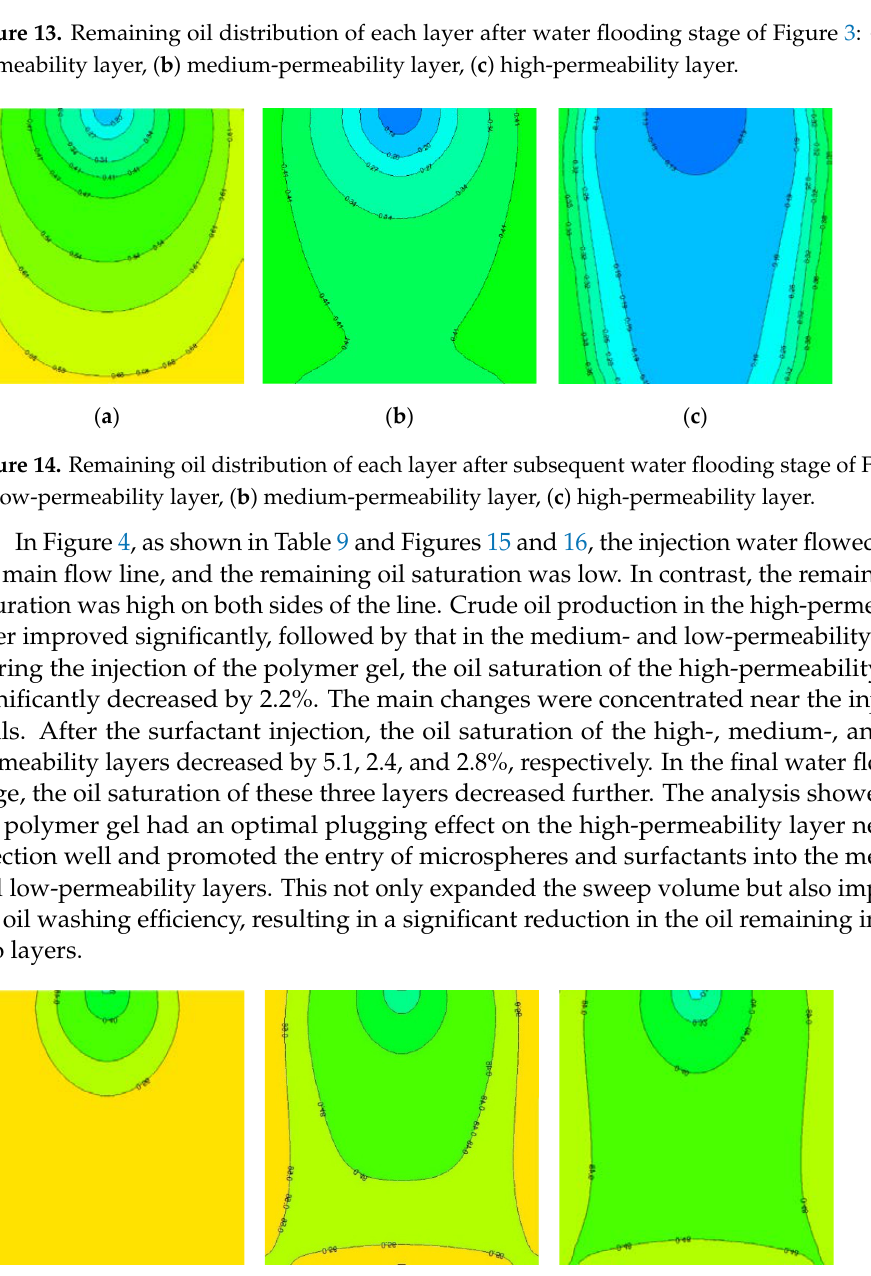
( c ) Figure 16. Remaining oil distribution of each layer after subsequent water flooding stage of Figure 4: ( a ) low-permeability layer, ( b ) medium-permeability layer, ( c ) high-permeability layer . Table 9. The remaining oil saturation (%) results of Figure 4 . Well Pattern Types Injection Stage Vertical Well Pattern ( Figure 4 ) Low-Permeability Layer